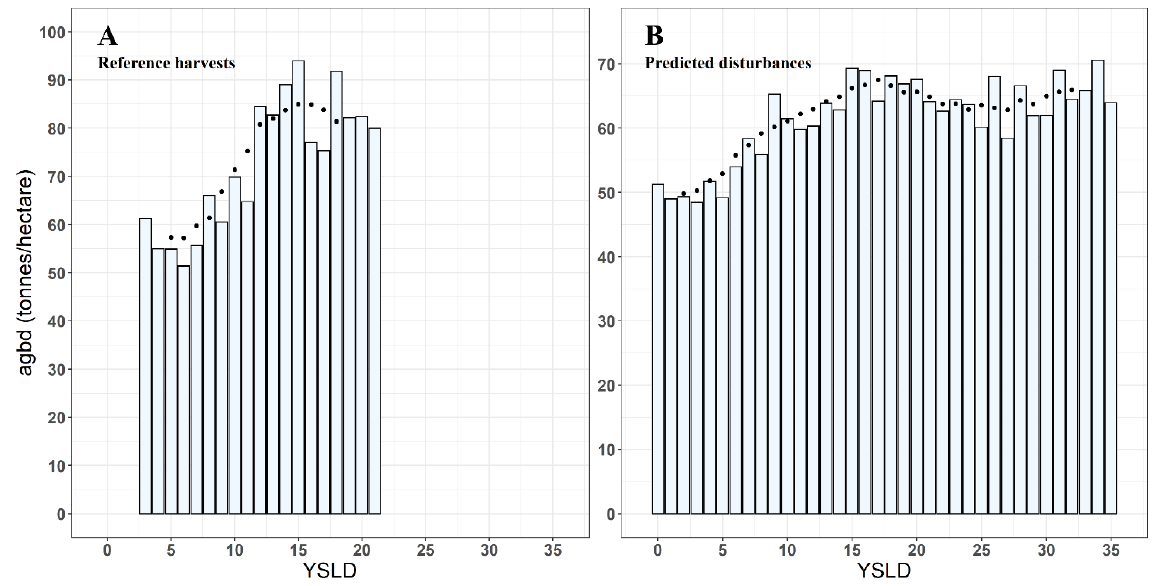
Figure 6. Median of AGBD values per YSLD in the reference dataset of forest harvestings ( A ) and all forest disturbances predicted across Italy ( B ). The black points show average values calculated using a moving window of 5 YSLD.